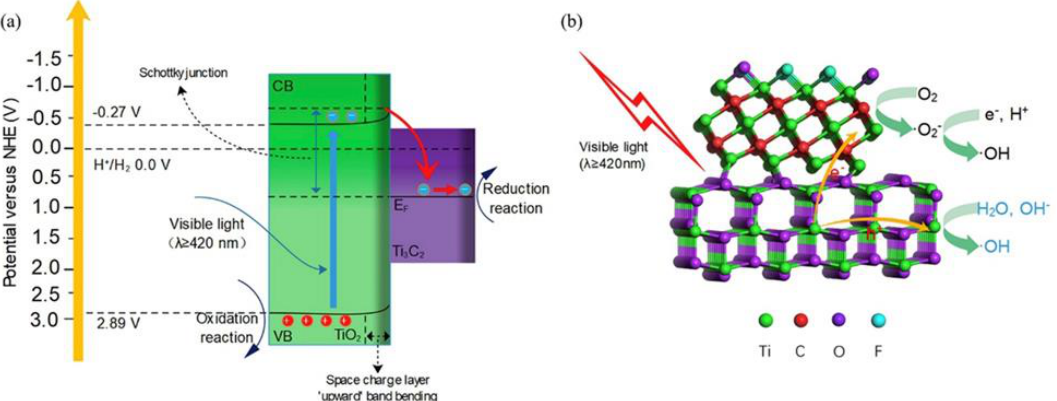
Figure 4. ( a ) Charge transfer process in TiO 2 /M-MXene photocatalyst in visible-light system and ( b ) proposed photocatalytic degradation mechanism of RhB using TiO 2 /M-MXene. (Reprinted with permission from Ref. [52]. 2020 Elsevier).